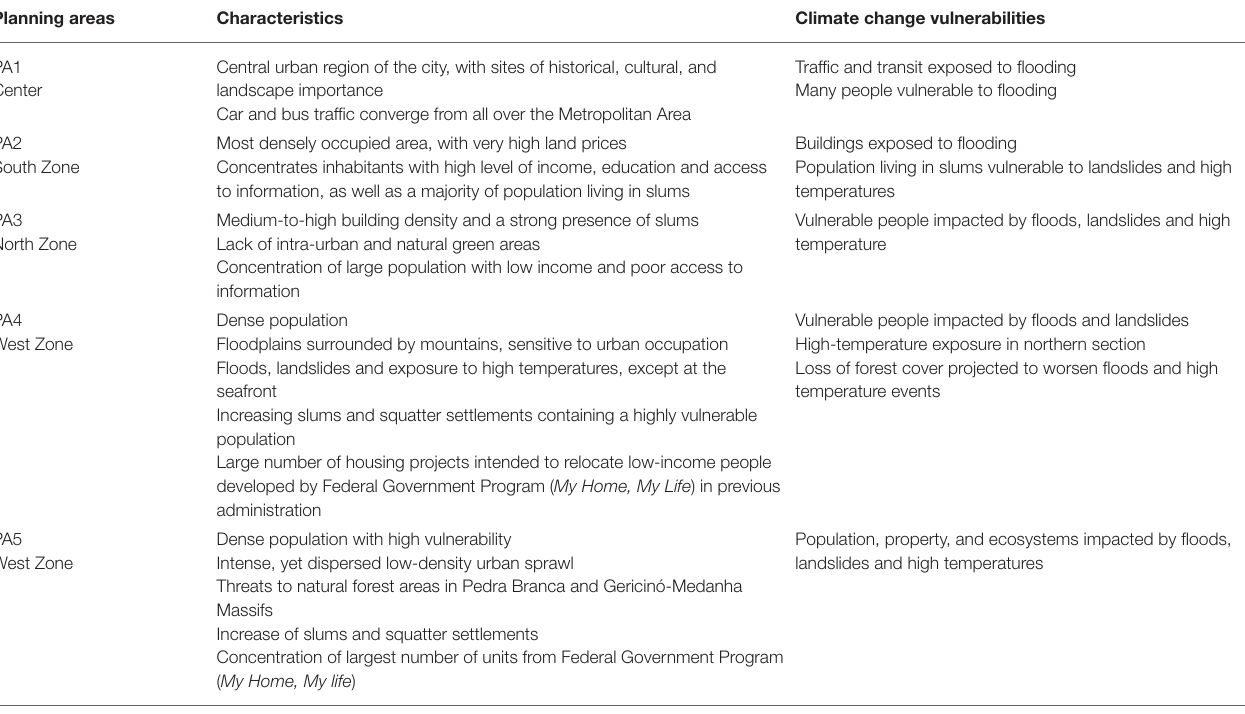
TABLE 1 | Socio-ecological and biophysical aspects of climate change vulnerabilities for Planning Areas in Rio de Janeiro. Planning areas